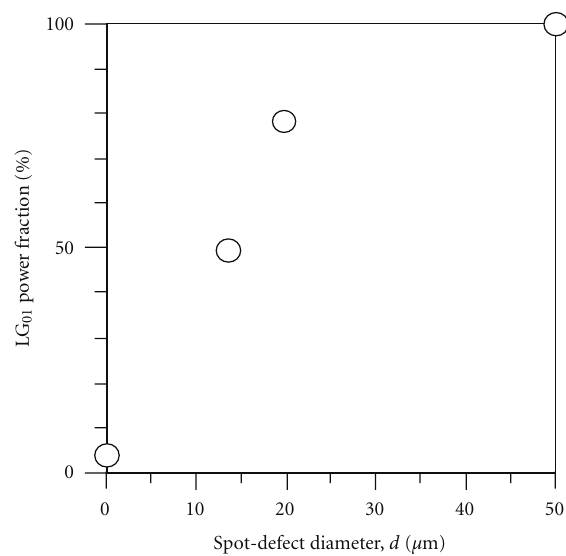
Figure 3: LG 01 power fractions for di ff erent spot defect diameters d (open circles).